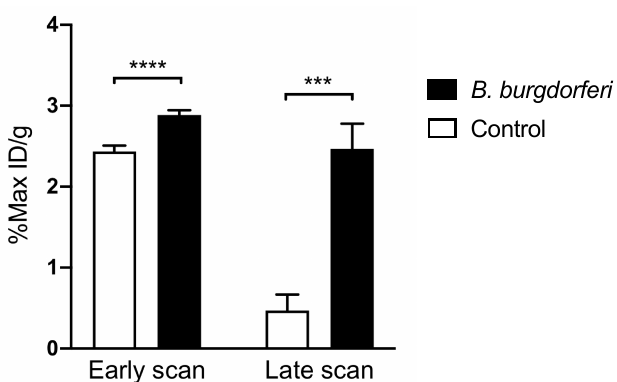
Figure 4. In vivo quantification of accumulated 64 Cu-DOTATATE in mice inoculated with B. burgdorferi ( n = 18) or PBS ( n = 6) . Data are presented as maximal percentage of injected dose per gram tissue (%Max ID/g) in each joint and acquired 3 h (early scan) and 48 h (late scan) p.i. 3 weeks post-infection. Data are presented as mean ± SEM. The significance level is indicated by asterisks (*). p = 0.0005 (***) and p < 0.0001 (****).